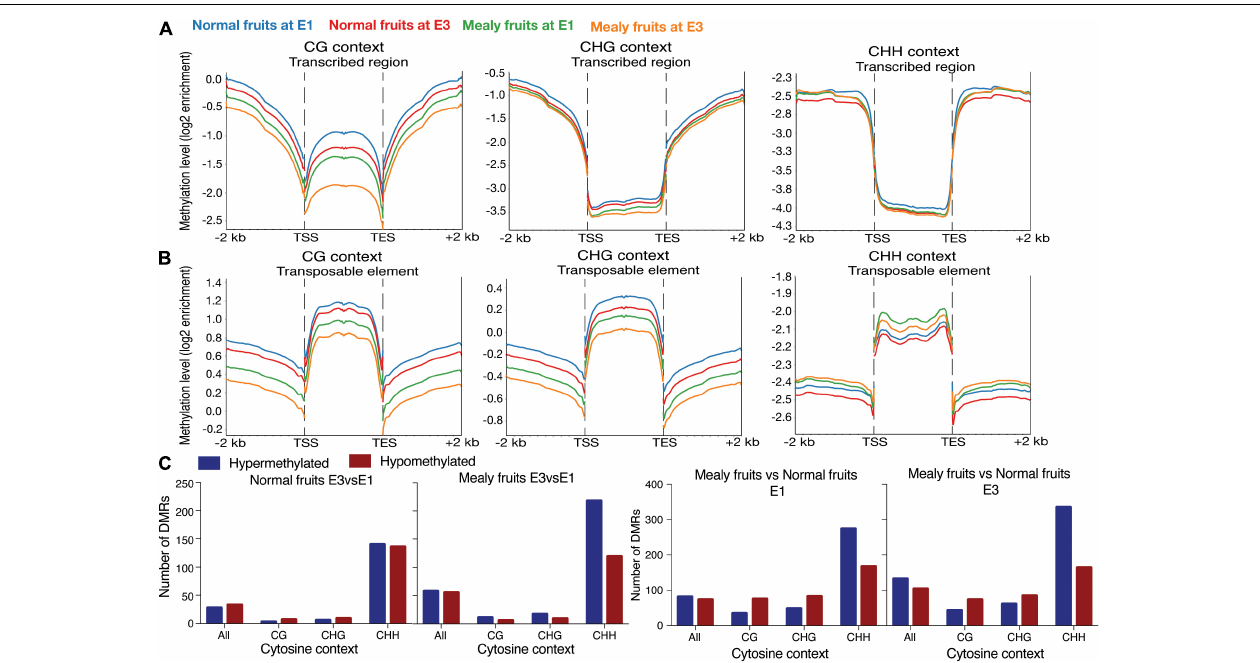
FIGURE 3 | Average distribution of global DNA methylation throughout coding regions and number of differentially methylated regions. (A) DNA methylation level in annotated genes, including 2 kb upstream and downstream of the transcription start site (TSS) and transcription end site (TES), respectively. Each color represents a different condition. (B) DNA methylation level in annotated transposable elements (TE), including 2 kb upstream and downstream of TSS and TES. (C) Number of Differentially Methylated Regions (DMRs) close to annotated genes (up to 2 kb upstream and downstream) in normal fruits at E3 vs. E1 stages, mealy fruits at E3 vs. E1, mealy fruits vs. normal fruits at E1 and mealy fruits vs. normal fruits at E3. Blue bars indicate hypermethylated regions and red bars hypomethylated regions. DMRs where considered in all cytosine contexts and individual contexts (CpG, CHG, and CHH). Three biological replicates, a log2 enrichment difference > 1 and a p -value < 0.05 were considered to identify a DMR.